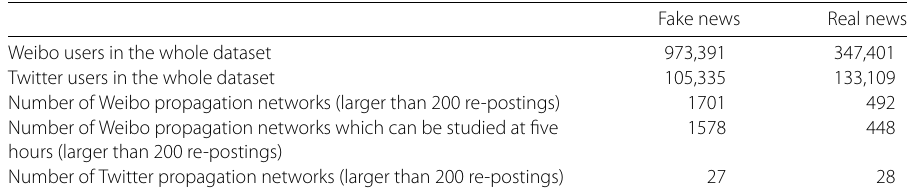
Table 1 Number of users and networks for different propagation networks